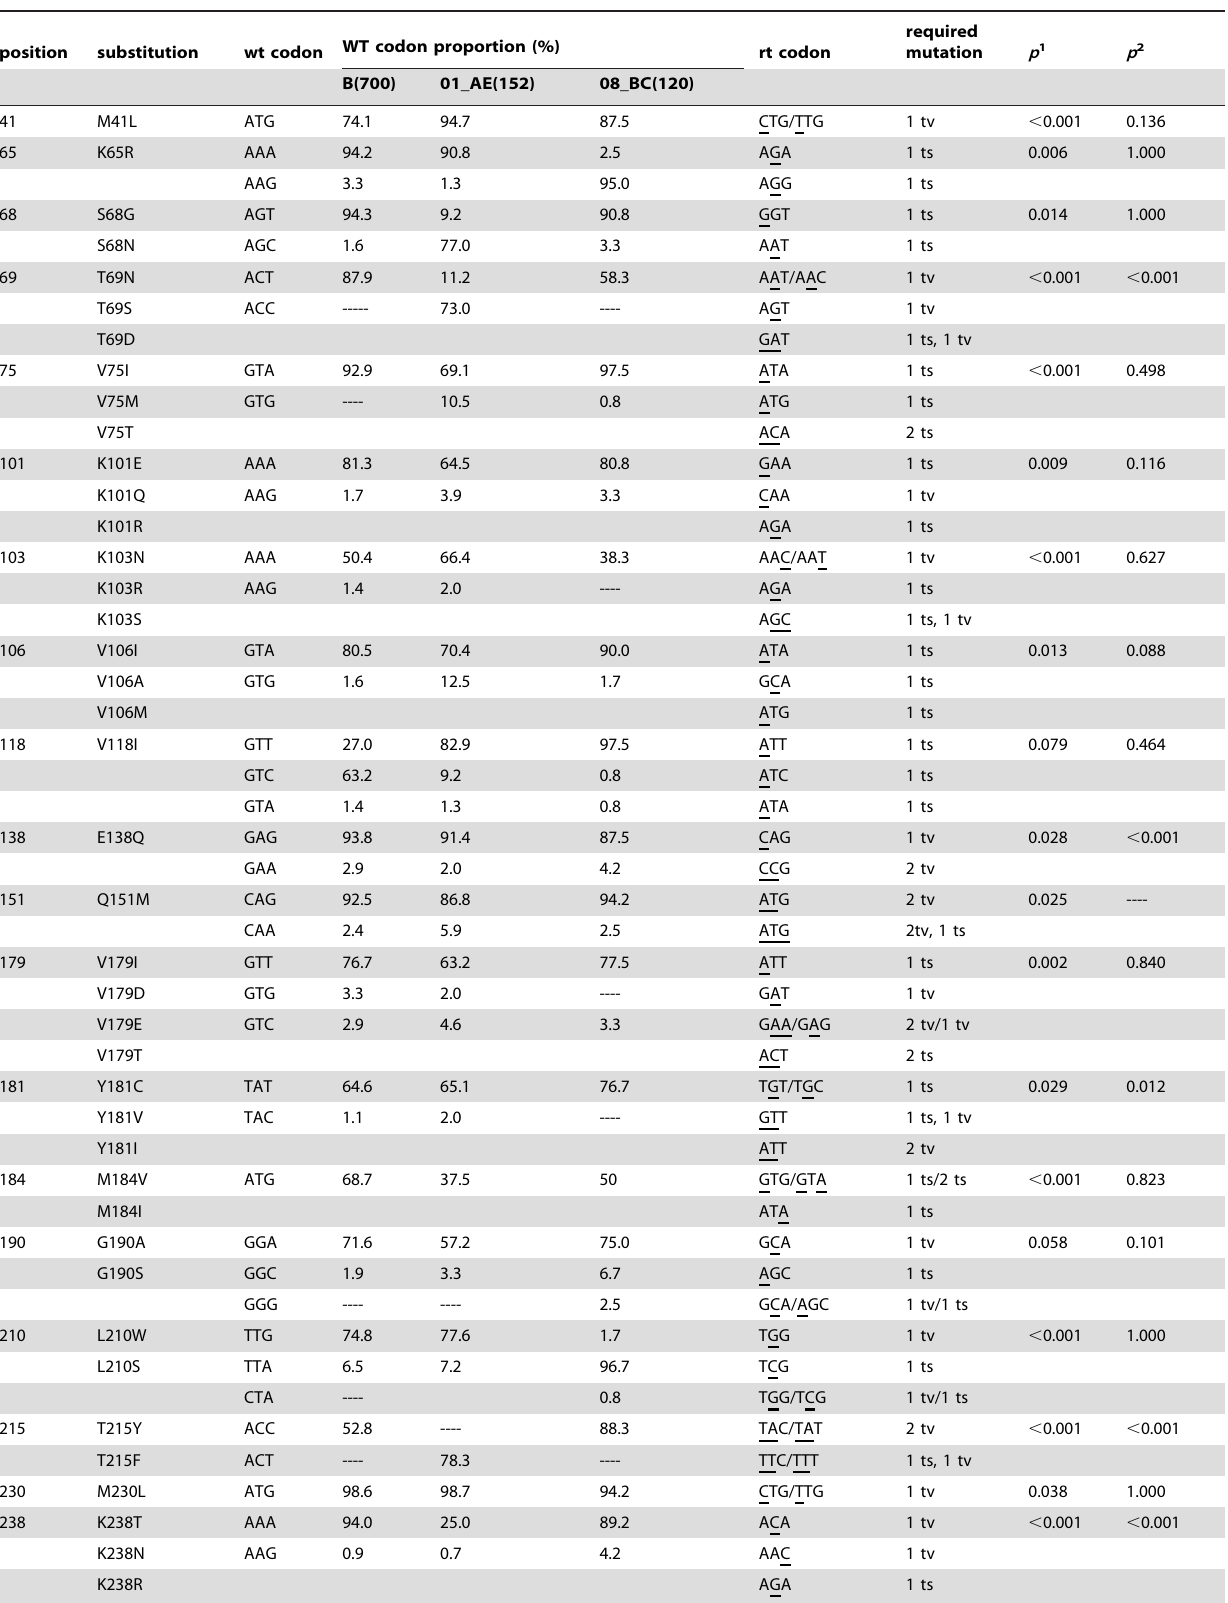
Table 2. Prevalence of wild type codons and genetic barriers of drug resistance mutation